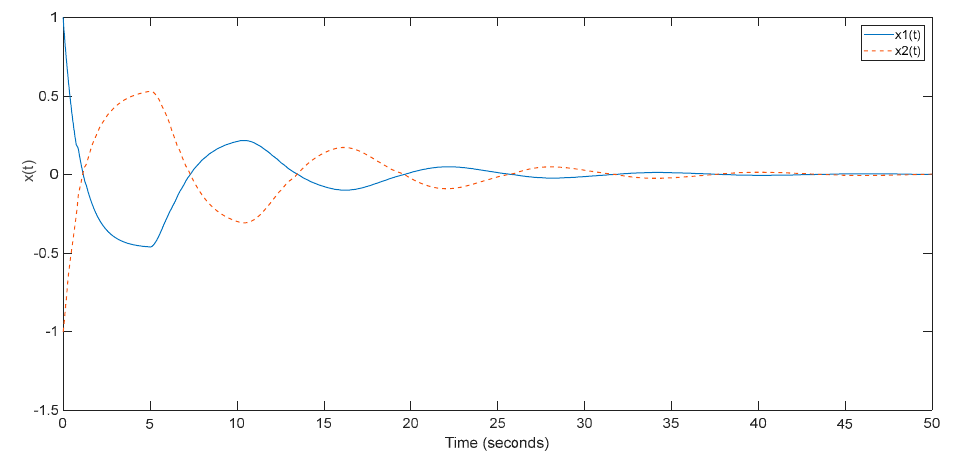
Figure 4. Regulated output for synchronous signal in (19) and input in (20) with zero disturbance input.